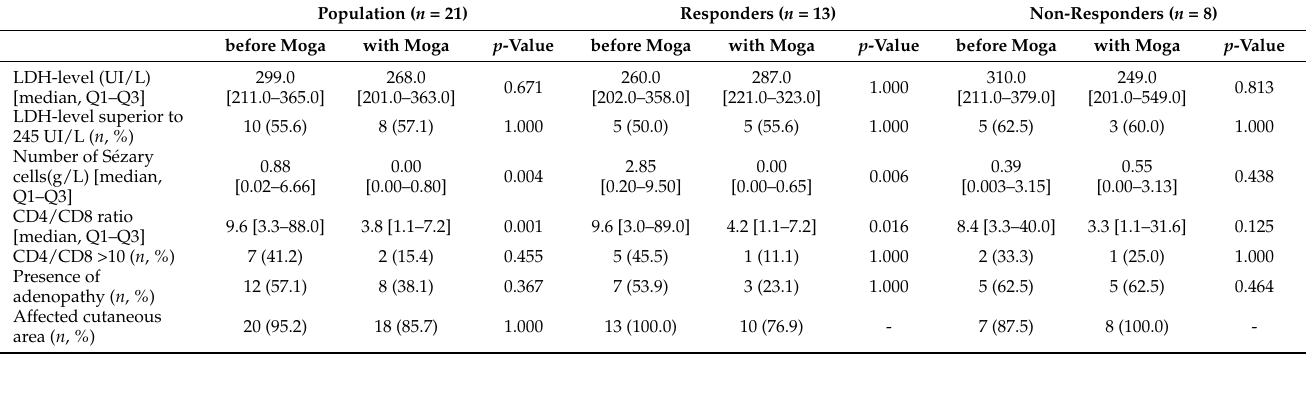
Figure 2. Kaplan–Meier survival analysis of occurrence of first all-grade adverse event among the 21 patients. No missing data.